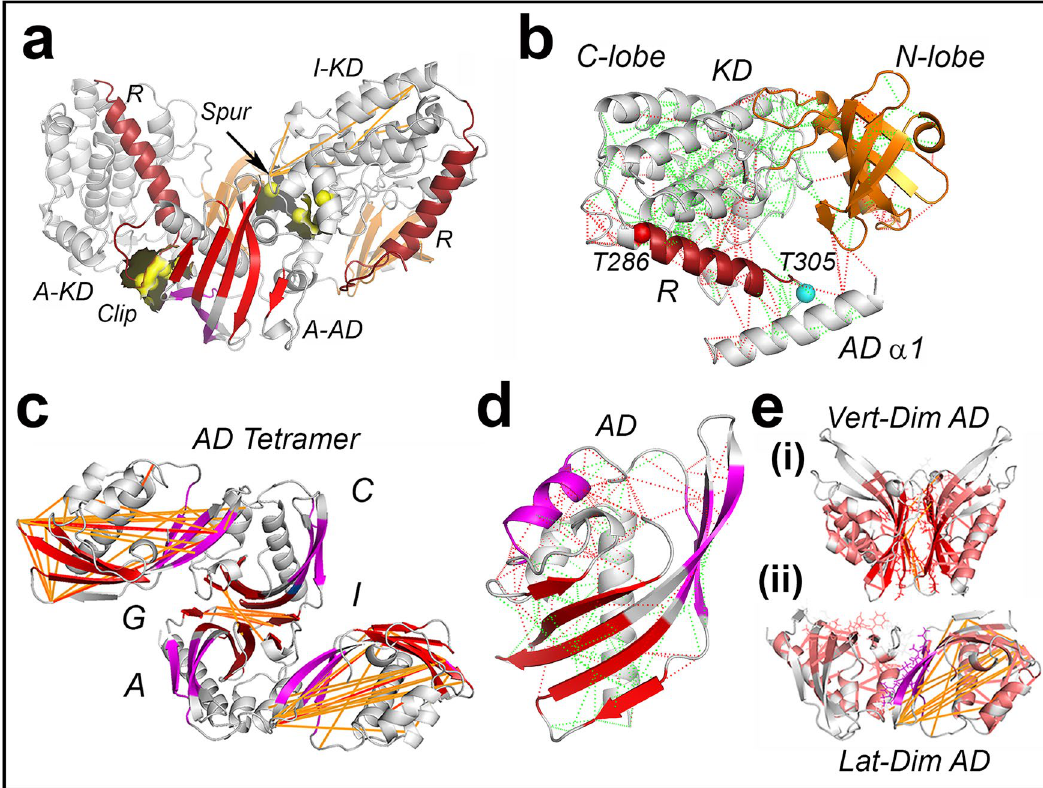
Figure 2. The dynamics and evolution of the CaMKII AD. Hub interfaces and R helix are color-coded as in Fig. 1a. ( a , b ). KD–AD Contact. ( a ). Dynamics. The top dynamic couplings computed between 4-residue fragments (yellow (weak) → orange → red (strong)). The KD–AD contact residues and surface (yellow). ( b ) Energetics. Energy frustration—(relaxed (green), stressed (red)). Spheres denote T286 (red), T305 (cyan). ( c , d ) AD Fold. ( c ) Interfacial dynamics. ACGI AD tetramer. The dynamic couplings span the interfaces (Vert-Dim (red), Lat-Dim (purple). Supplementary Video S3). ( d ) Energetics. Energy frustration scores are color coded as in B. ( e ) Residue Coevolution. The superposition of the dynamic (thin orange lines) and coevolved (thick salmon lines) couplings adjacent to the (i) Vert-Dim and (ii) Lat-Dim contacts (stick sidechains). 3D-views in Supplementary Videos S4–S7. Source listed in Table